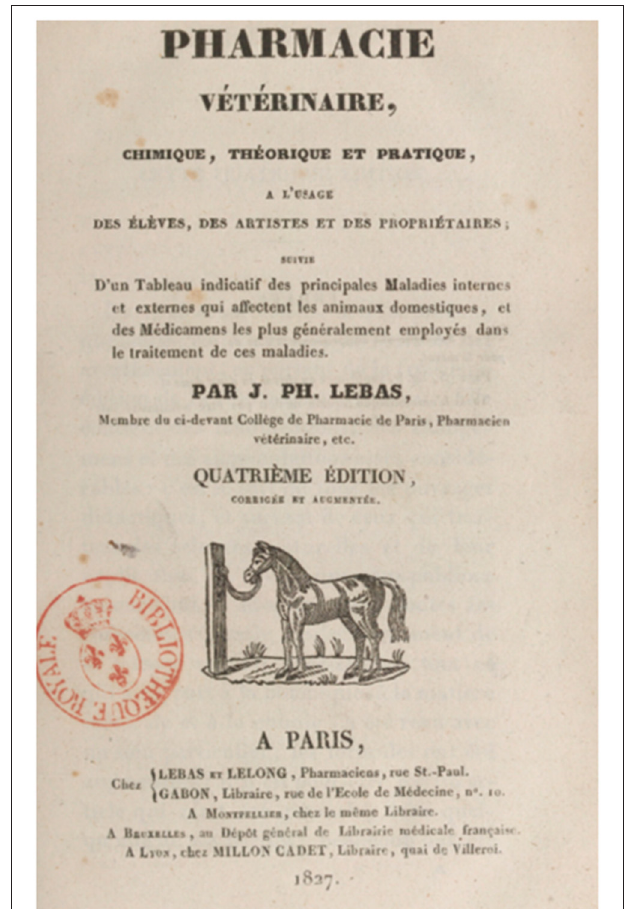
FIGURE 2 | Early French textbook on Veterinary Pharmacy by Lebas (23). Analyzing this 1823 edition ( 23), Girard (24) one of the most famous professors at Alfort wrote: it is only to aid memory and to facilitate research. The disease being recognized, the artist chooses from the series of medicines which are